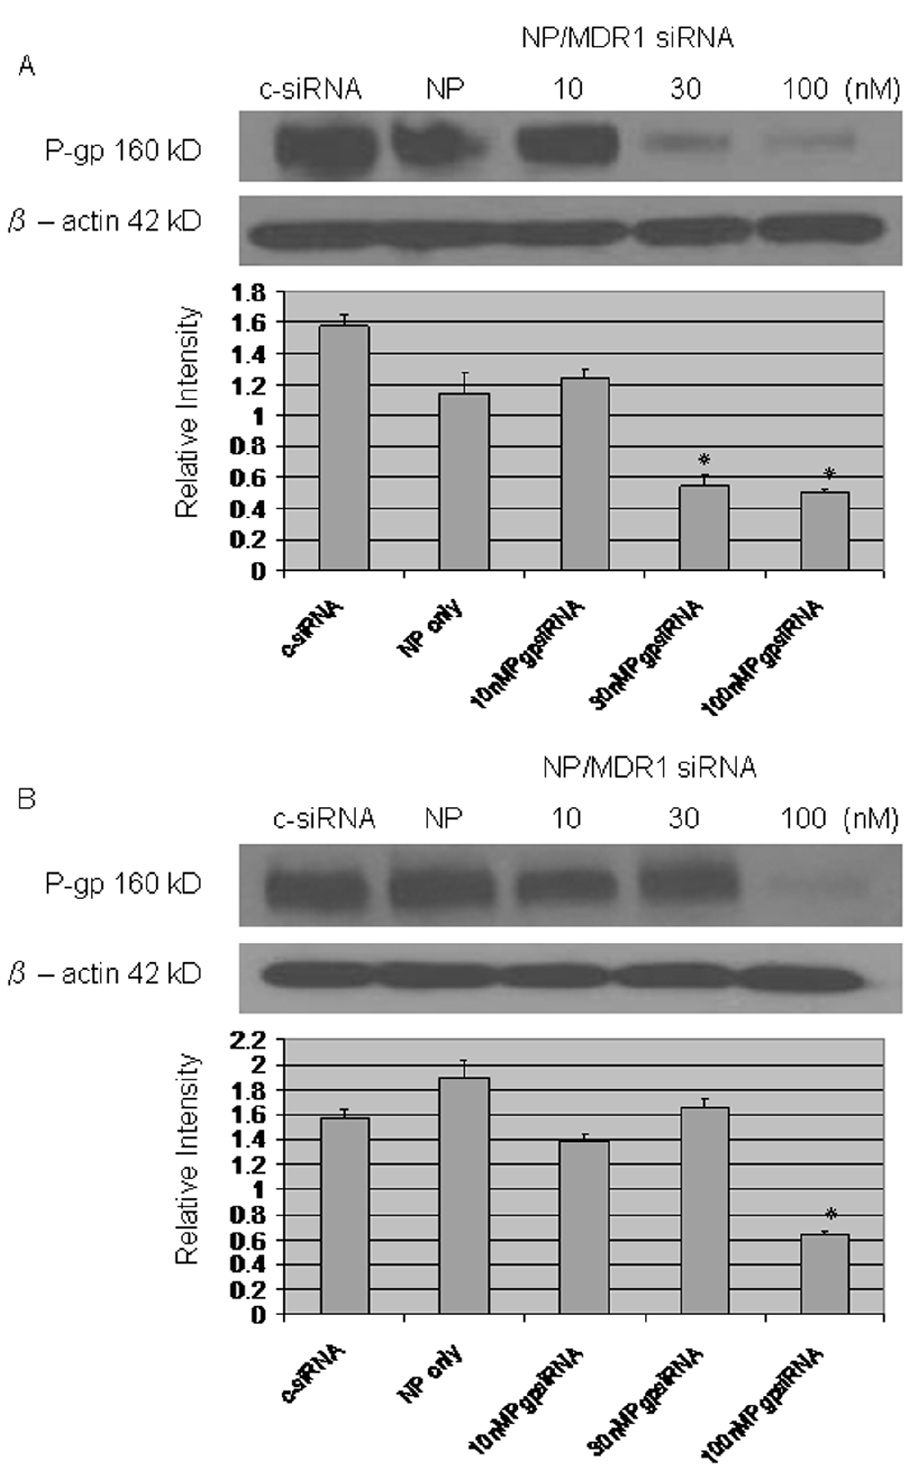
Figure 3. Western blot assay was performed to assess the effect of MDR1 siRNA loaded nanoparticles on expression of P-gp. The expression of P-gp was significantly decreased after application of 30 nM MDR1 siRNA loaded nanoparticles for KHOS R2 ( A ) and 100 nM MDR1 siRNA loaded nanoparticles for U-2OS R2 ( B ). P values are shown as follows: * P , 0.05.